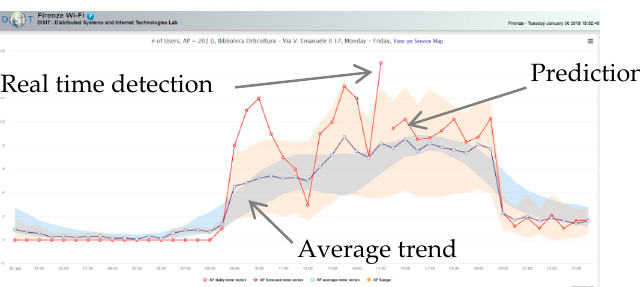
Figure 9. An example of trend related to a certain AP along the daily 24 h (blue line), the current detection (red line) and the subsequent prediction (red line after the gap).